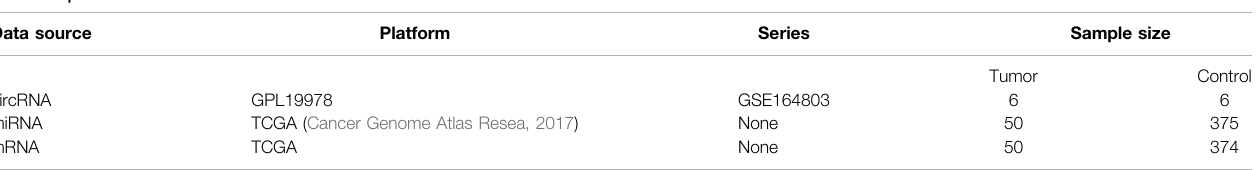
TABLE 1 | Basic characteristics of three datasets in the GEO and TCGA